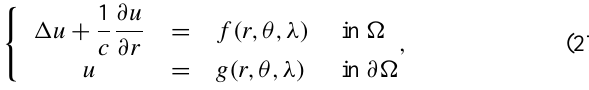
where c = 6 km and σ 0 = 5 × 10 − 14 sm − 1 . In this